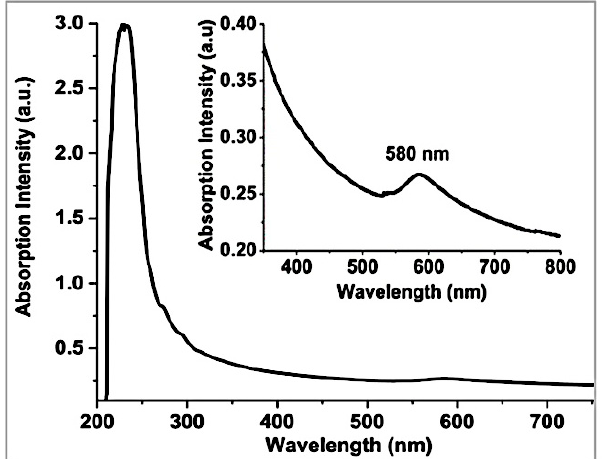
Figure 2. UV–visible absorption spectrum of a typical Cu / gCN nanomaterial synthesized using pulsed laser ablation in acetonitrile. The inset shows a vertically expanded region of the spectrum around the position of the surface plasmon resonance for Cu NPs.